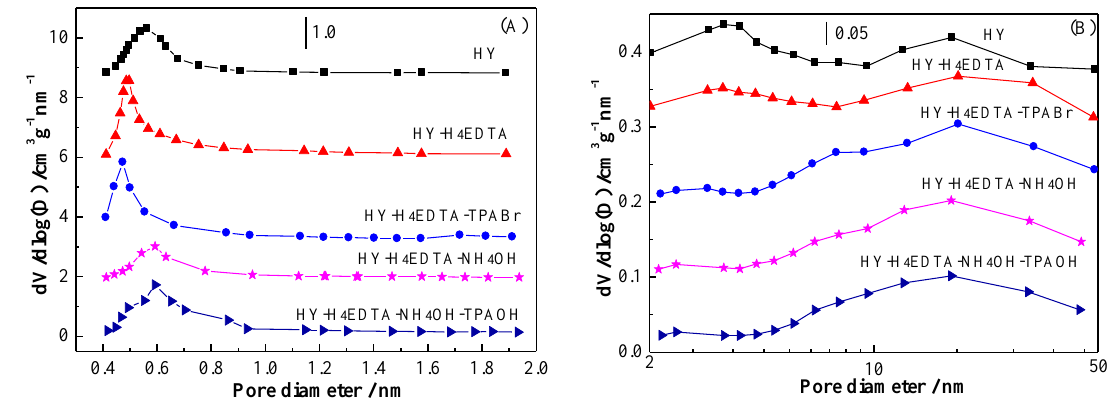
Figure 4. The micropore pore size ( A ) and mesopore pore size ( B ) distribution of the parent HY and the optimized hierarchical HY zeolites.